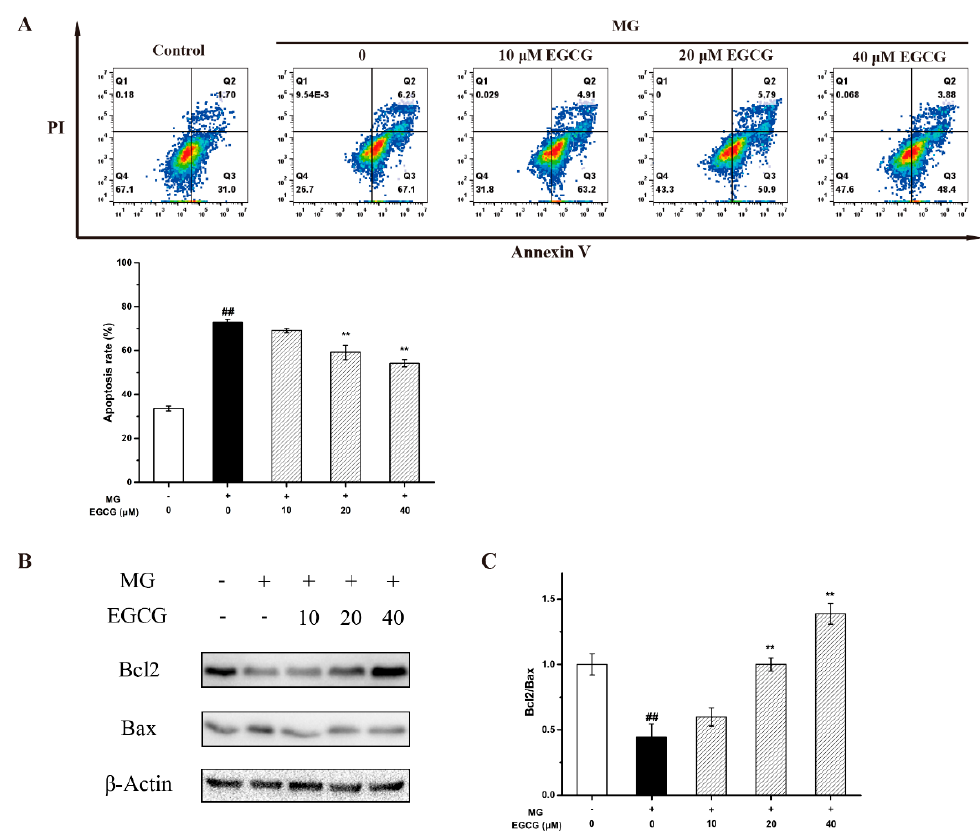
Figure 4. Effects of EGCG on MG-induced PC-12 cells’ apoptosis. ( A ) Analysis of cell apoptosis by flow cytometry. ( B ) Western blot results of the expression levels of Bcl2 and Bax. ( C ) Statistical analysis of the expression levels of the ratio of Bcl2 and Bax. Data shown are the mean ± SD of three independent experiments. ## p < 0.01 compared with the control.** p < 0.01 compared with the MG group.